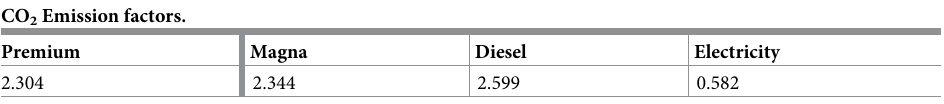
Table 4. Electricity, Diesel, premium and magna gasoline emission